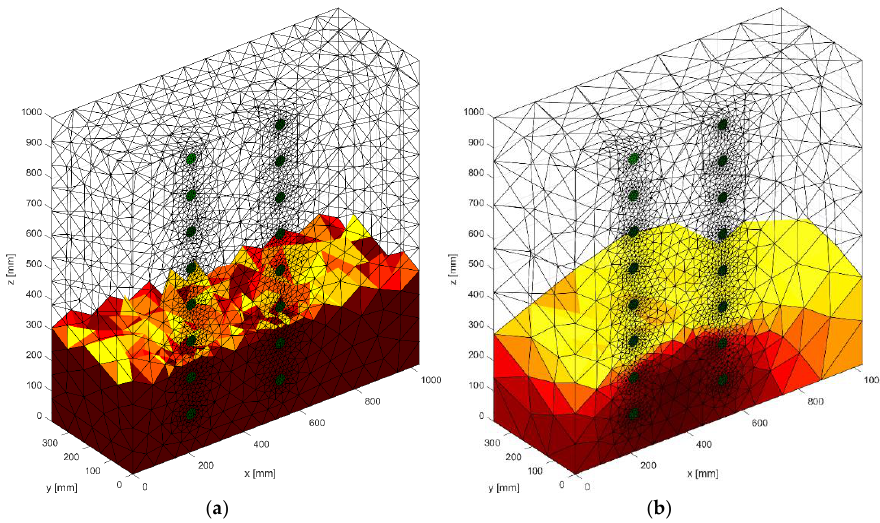
Figure 11. The geometrical model 3D with 2 × 8 electrodes—the image reconstruction: ( a ) pattern model, ( b ) reconstruction created with the use of Gauss-Newton method with Laplace regularization.